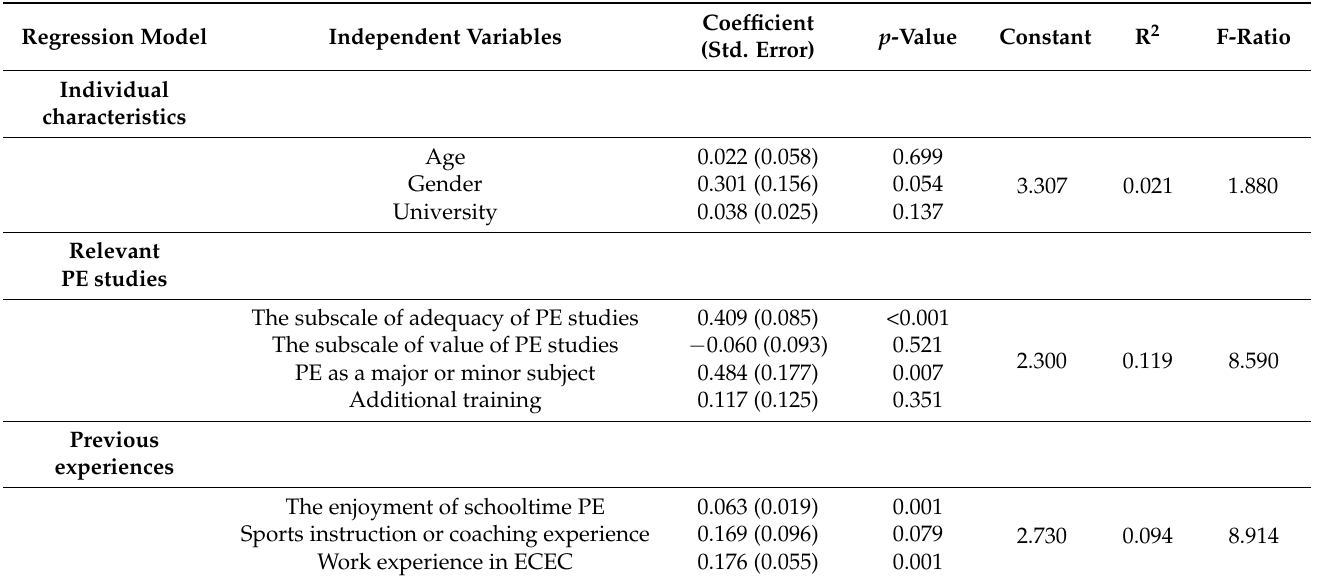
Table 5. Linear regression results for observing and assessing a child’s motor skills and